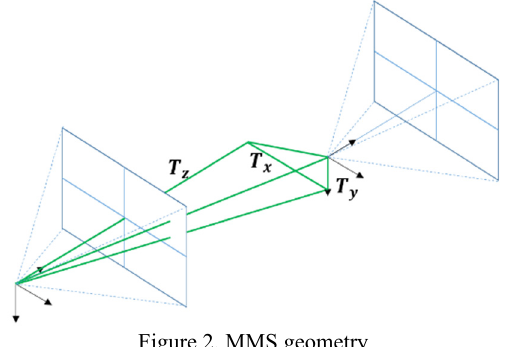
Figure 2. MMS geometry